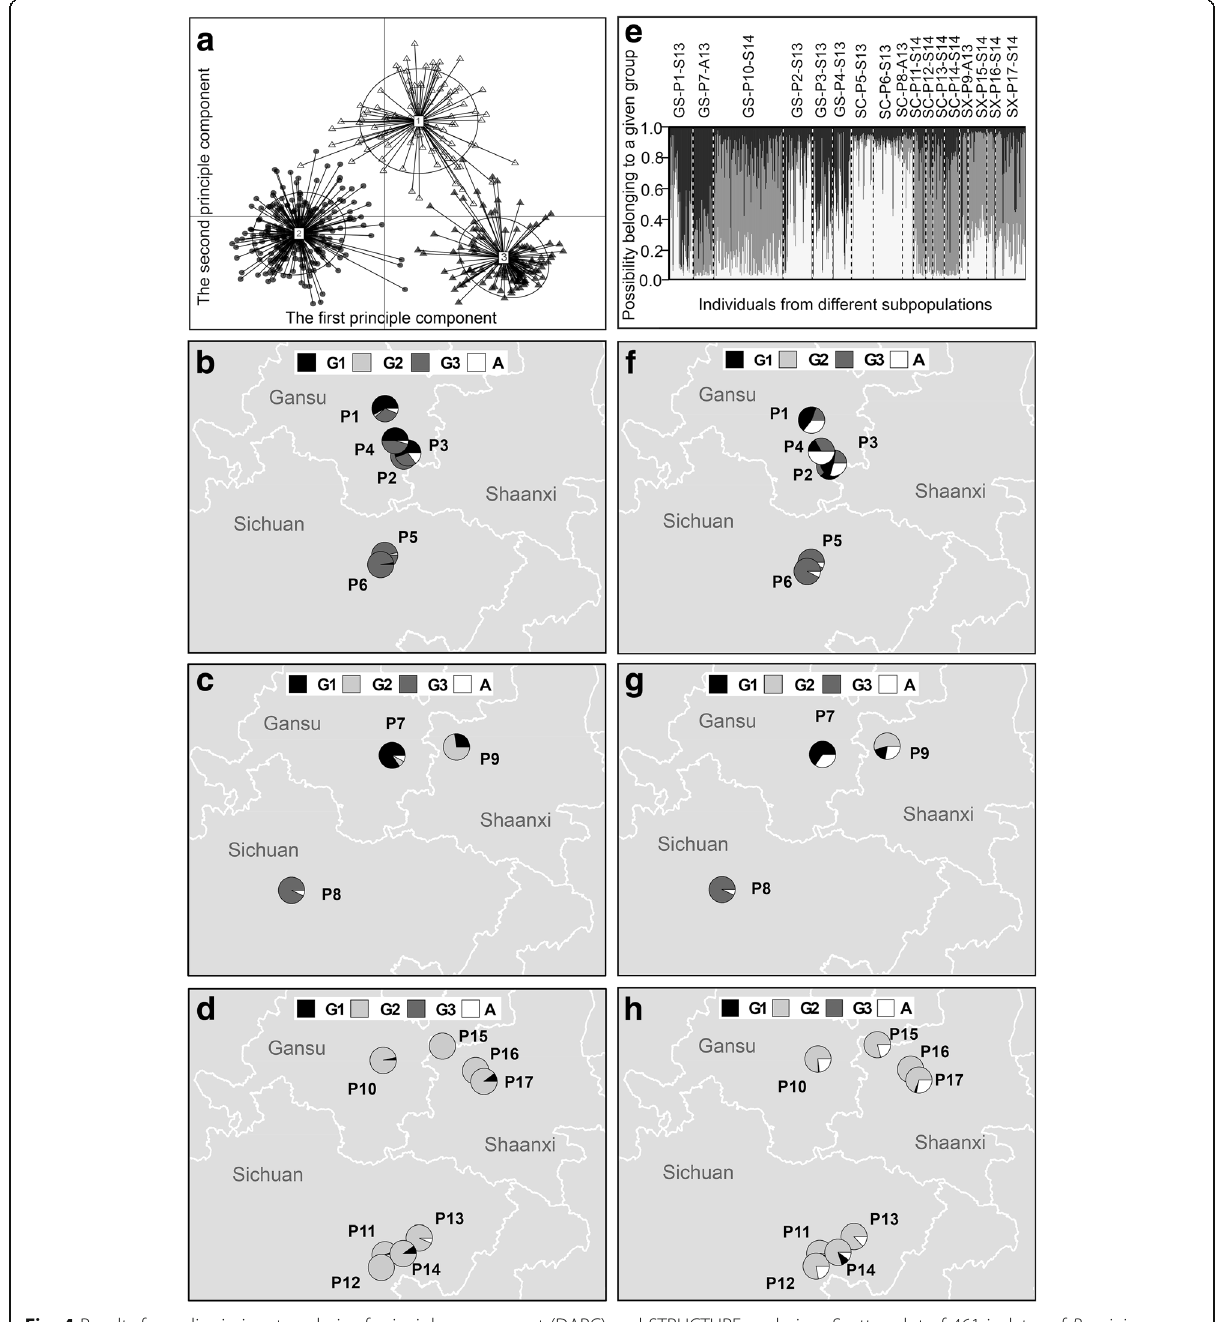
Fig. 4 Results from discriminant analysis of principle component (DAPC) and STRUCTURE analysis. a Scatter-plot of 461 isolates of Puccinia striiformis f. sp. tritici according to DAPC. The symbols of “ △ ” , “ ● ” , and “ ▲ ” represented isolates belonging to genetic groups 1, 2, and 3, respectively. b, c and d The frequency and geographical distribution of isolates assigned to genetic groups G1, G2, G3 and admixture (A) in subpopulations collected in spring 2013, autumn 2013, and spring 2014, respectively, according to DAPC. e Bayesian assignment of individual isolates into three genetic groups (black for G1, grey for G2, and white for G3) in STRUCTURE analysis. f, g and h The frequency and geographical distribution of isolates assigned to groups G1, G2, G3 and A in subpopulations collected in the spring of 2013, autumn of 2013 and spring of 2014, respectively, according to STRUCTURE analysis. A individual was assigned to a group if it had a probability no less than 80, and 60% belonging to the group in DAPC, and STRUCTURE analysis, respectively, otherwise it would be assigned to group A. Population code (P1-P17) was abbreviated from GS-P1-S13, GS-P2-S13, GS-P3-S13, GS-P4-S13, SC-P5-S13, SC-P6-S13, GS-P7-A13, SC-P8-A13, SX-P9-A13, GS-P10-S14,